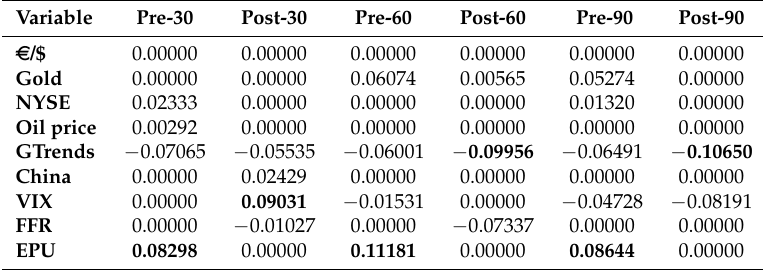
Table A2. PC-LASSO coefficients for